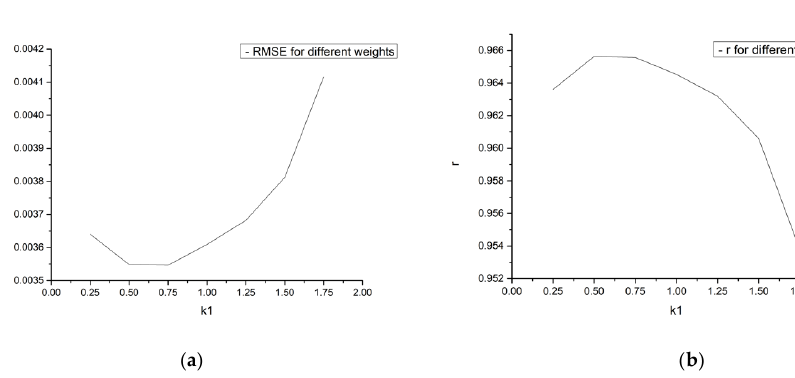
Figure 13. The ( a ) RMSE and ( b ) r of the fusion results with applying different weights for k 1 and k 2 in the HNN-SPOT algorithm.